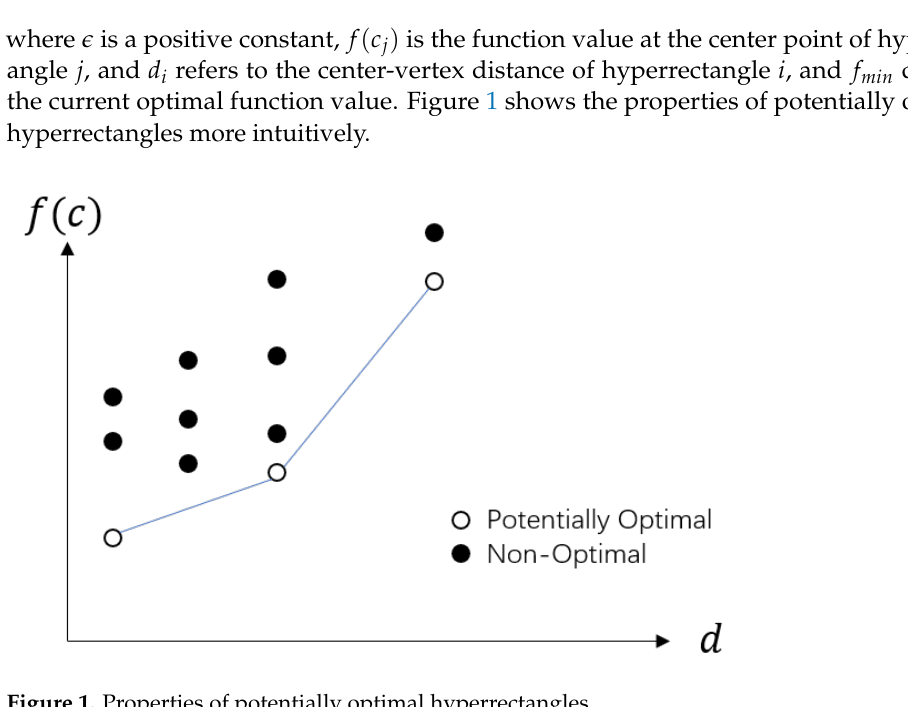
Figure 1. Properties of potentially optimal